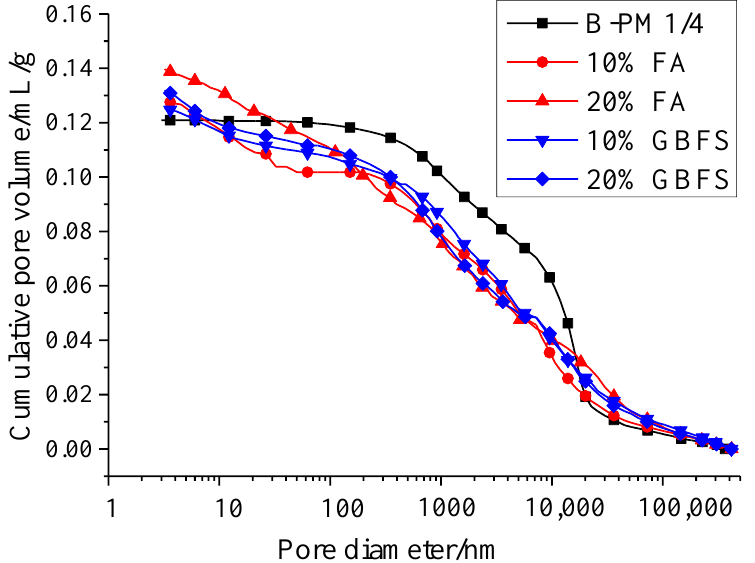
Figure 3. Effect of mineral admixtures on porosity of MPC. Table 5. Effect of mineral admixtures on pore structure of MPC.